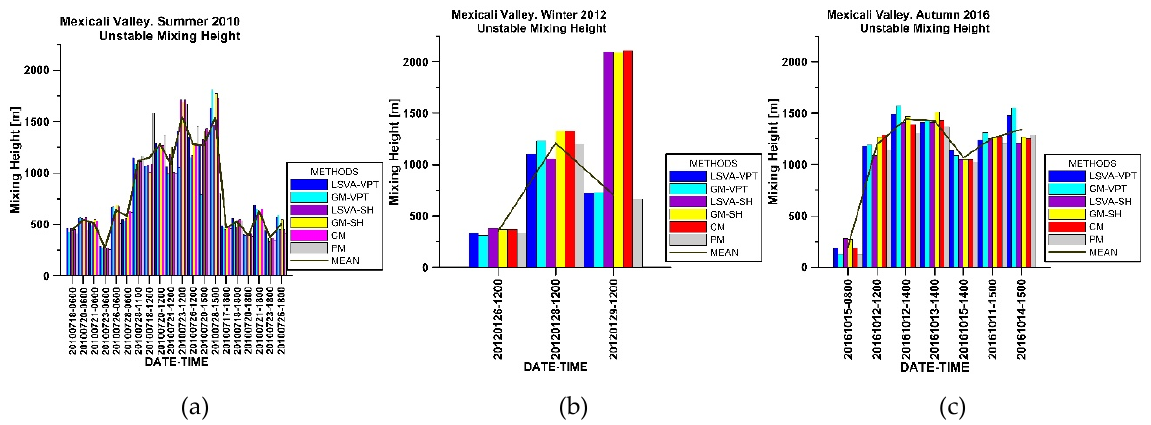
Figure 10. Estimations of the convective mixing height with the LSVA / VPT, GM / VPT, LSVA / SH, GM / SH, CM, and PM. ( a ) Summer 2010, ( b ) winter 2012, and ( c ) autumn 2016. The graphs also show the mean value (solid line) over all the methods. The estimations obtained with the SH profile of the 12:00 LST sounding of 29 January 2012, reflected an atypical behavior of the specific humidity profile, and we discarded them when calculating the mixing height mean value.